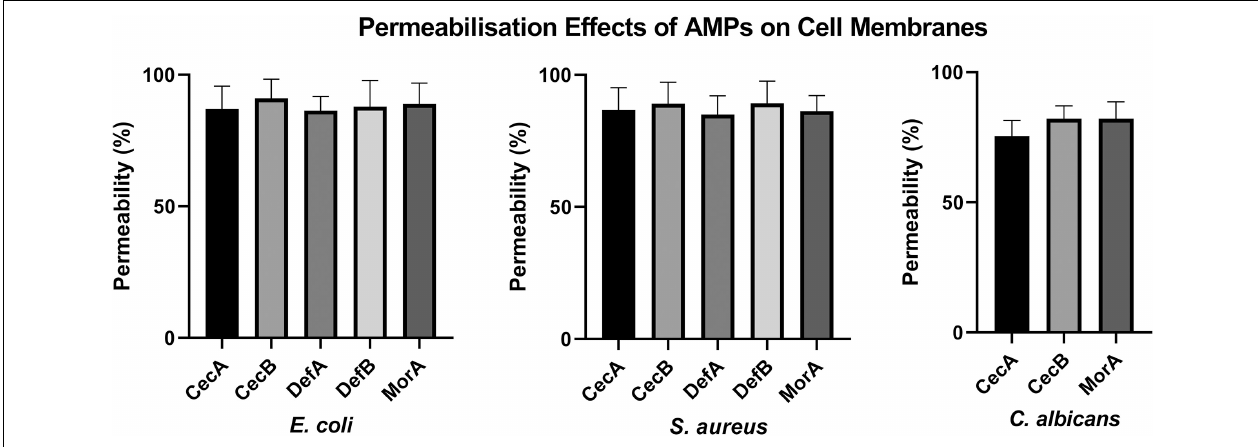
FIGURE 4 | Evaluation of membrane destruction effects of antimicrobial peptides (AMPs) by SYTOX Green uptake assay. Results demonstrated the synthetic peptides induced significant membrane permeability changes against different